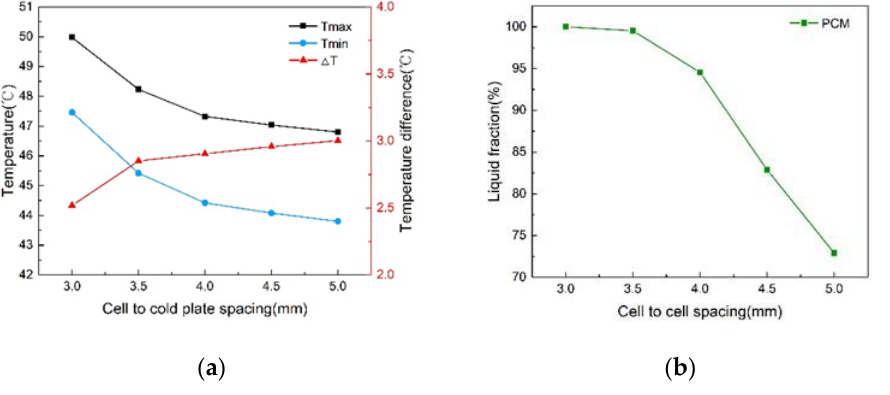
Figure 7. ( a ) T max , T min , and Δ T at different distances from battery to cold plate at 1800 s. ( b ) PCM liquid fraction at different distances from the battery to the cold plate at 1800 s.